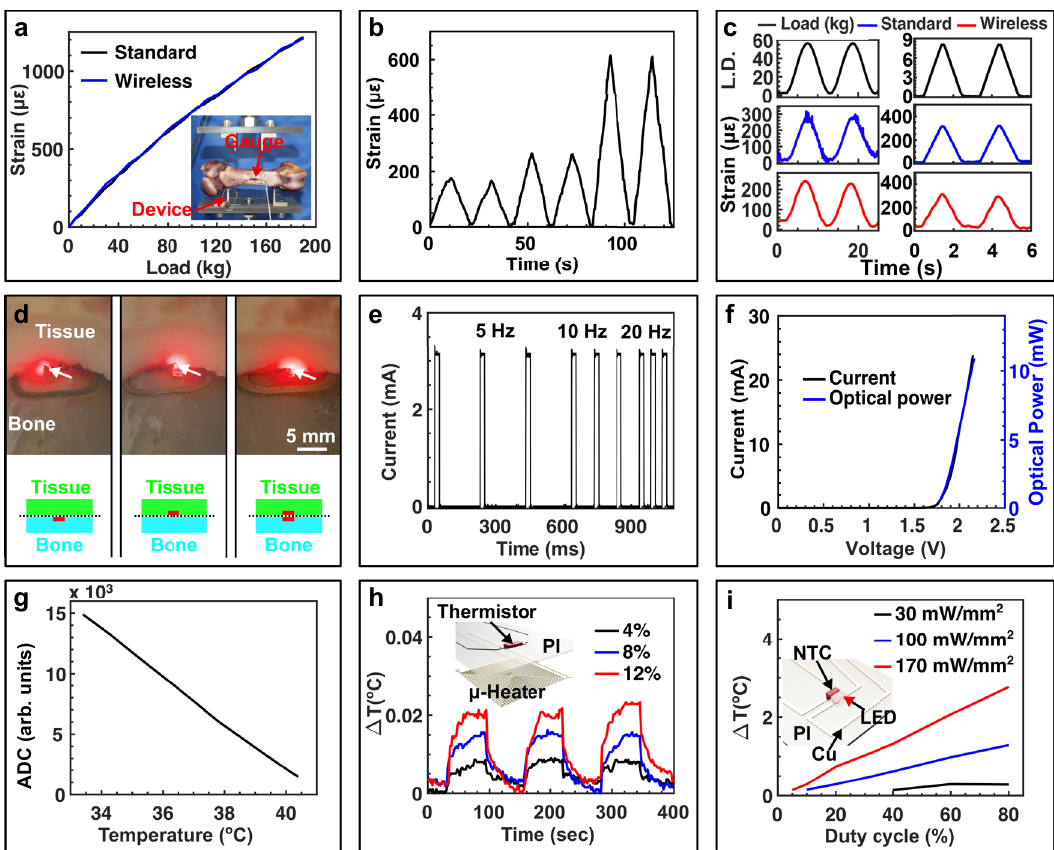
Fig. 3 Benchtop characterization of the biointerface. a – c Strain sensing module: comparison of strain – load curves measured using standard wired system and wireless OSE device ( a ); strain pro fi le measured with the wireless device under progressively increasing load ( b ); and strain pro fi les measured with wired system and wireless device under cyclic load ( c ). Benchtop test setup where the strain gauges are attached on a piece of sheep bone and the load is applied with a MTS system. d – f LED module: photographs of devices inserted at the bone – tissue interface, with µ -ILED on the bottom (left), on the top (middle), and on both sides (right) ( d ); current pro fi le of the µ -ILED operating at frequencies of 5, 10, and 20 Hz with pulse width of 20 ms ( e ); current and optical power as functions of driving voltage of the µ -ILED used ( f ). Scale bar in ( d ), 5 mm. g – i Thermal sensing module: wirelessly logged ADC values as a function of temperature ( g ); wirelessly measured change in temperature using the NTC thermistor with the micro-heater driven at various levels of power, demonstrating a sensing resolution of <10 mK ( h ); thermal impact of an µ -ILED operating at various optical powers and duty cycles in PBS solution measured wirelessly with a co-located NTC thermistor ( i ). Insets of ( h ) and ( i ), schemat i cs showing the layout of thermistor-micro-heater ( h ) and thermistor-LED front-end ( i